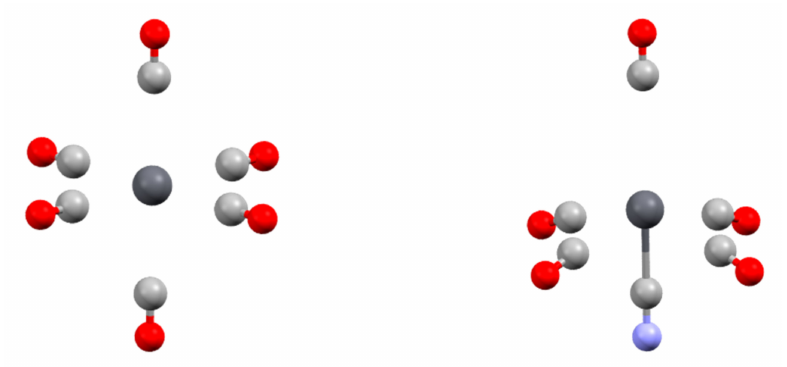
Figure 2. Structure of [Pb(CO) 6 ] 2+ ( left ) and [Pb(CO) 6 (CN)] + ( right ) complexes.